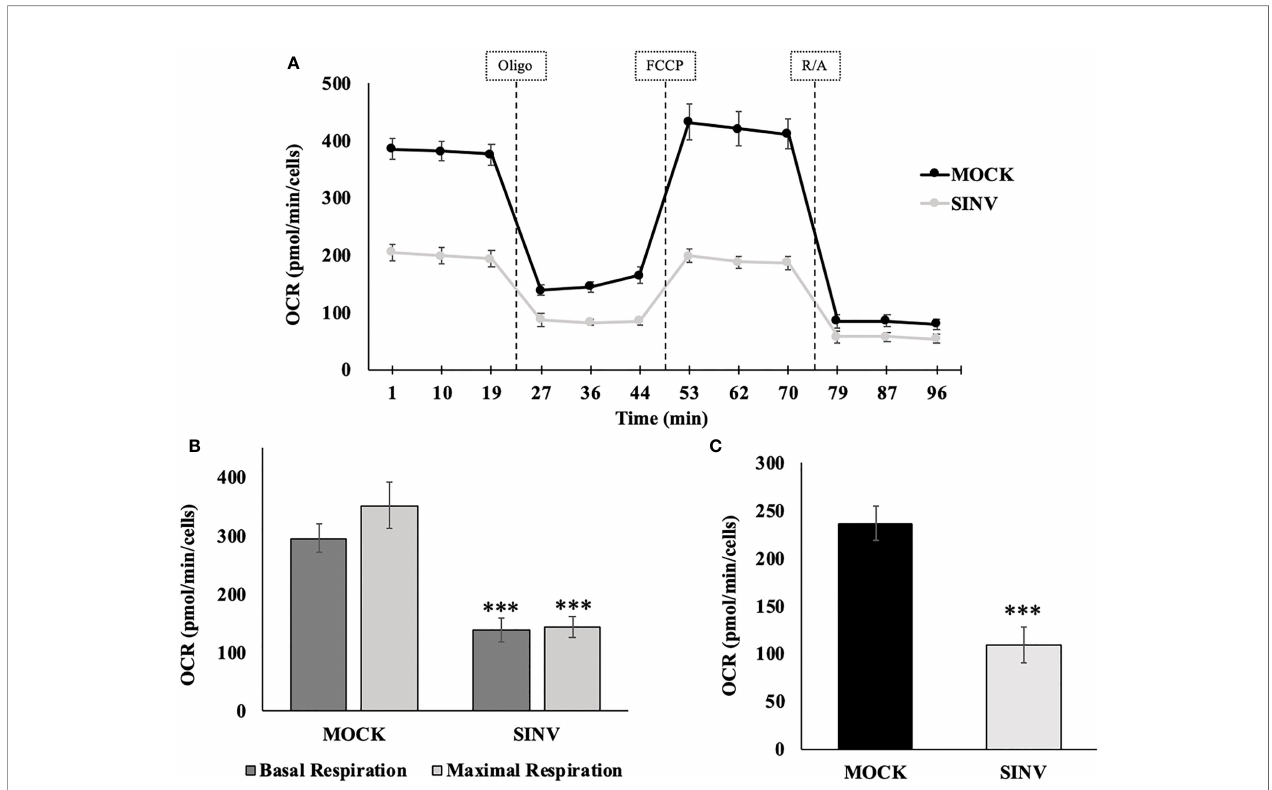
FIGURE 5 | Reduced oxygen consumption at 24 hours post infection. Infected Huh7 cells experience a state of mitochondrial dysfunction with reduced OCR for the purpose of ATP synthesis. (A) Metabolic mitochondrial pro fi les during addition of mitochondrial inhibitors. (B) Basal and maximal respiration as determined by the oxygen consumption rate (OCR). (C) ATP production differences between uninfected (mock) and SINV infected (SINV). (***) P-value < 0.001. Sample size n = 9.